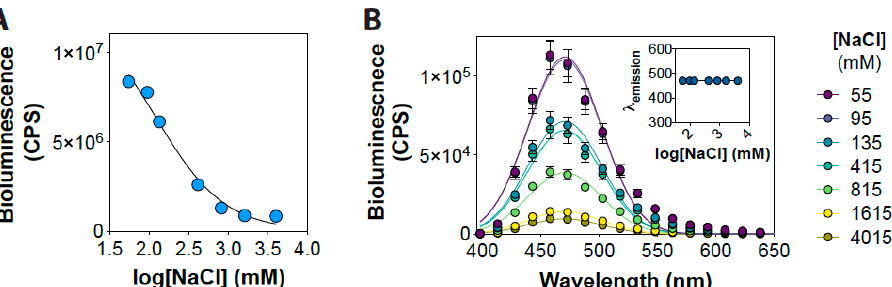
Figure 1. NaCl concentration-dependent NanoLuc activity. ( A ) Graph showing NanoLuc bioluminescence as a function of NaCl concentration. ( B ) Graph showing a wavelength scan of NanoLuc bioluminescence at indicated NaCl concentrations. Inset shows a graph emission max wavelength obtained from Gaussian fitting of the bioluminescence spectra. Data shown are mean ± standard error of mean (SEM) of 5 measurements from a representative experiment.